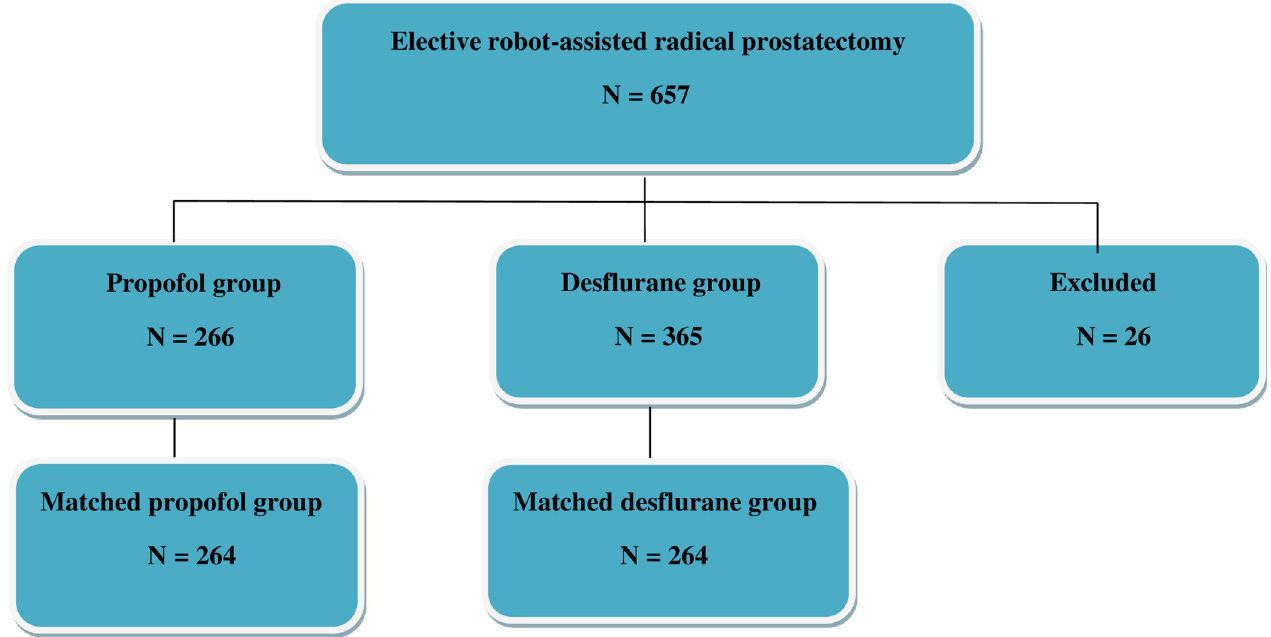
Fig 1. Flow diagram detailing the selection of patients included in the retrospective analysis. 26 patients were excluded due to combined propofol anesthesia with inhalation anesthesia or regional analgesia, desflurane anesthesia combined with regional analgesia, incomplete data, age < 20 years.